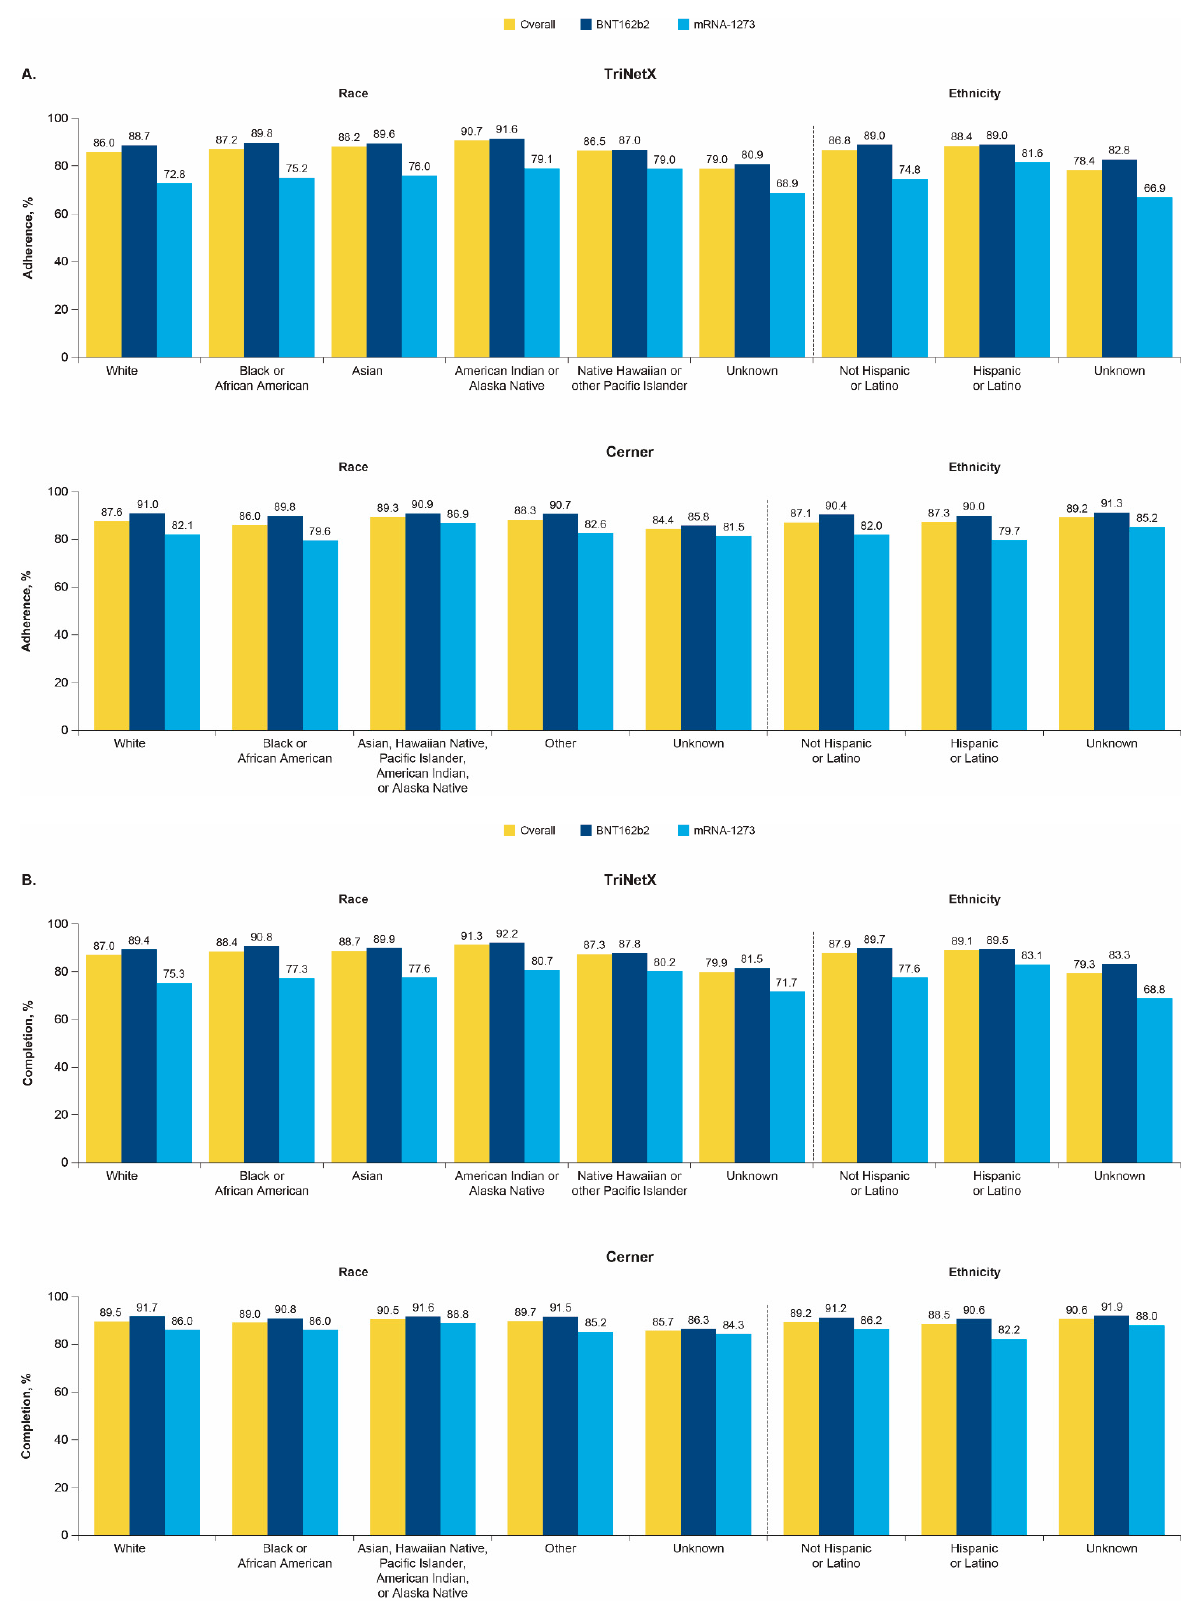
Figure 3. ( A ) Adherence and ( B ) completion stratified by race and ethnicity in the TriNetX and Cerner databases.